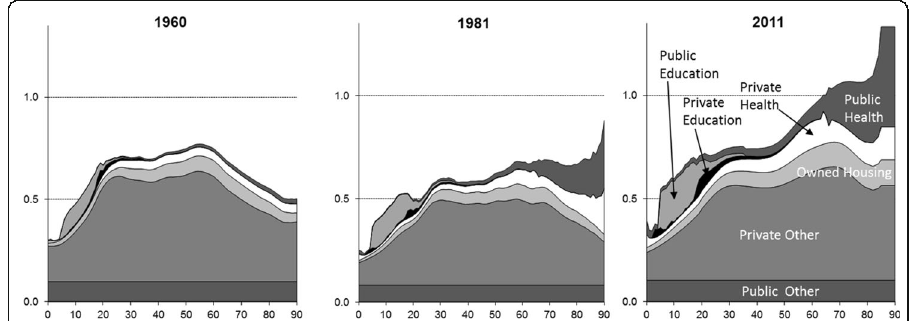
Fig. 2 Changes in age profile of US consumption over a half century. Source: Updated from Lee, Donehower and Miller (2011) using National Transfer Accounts